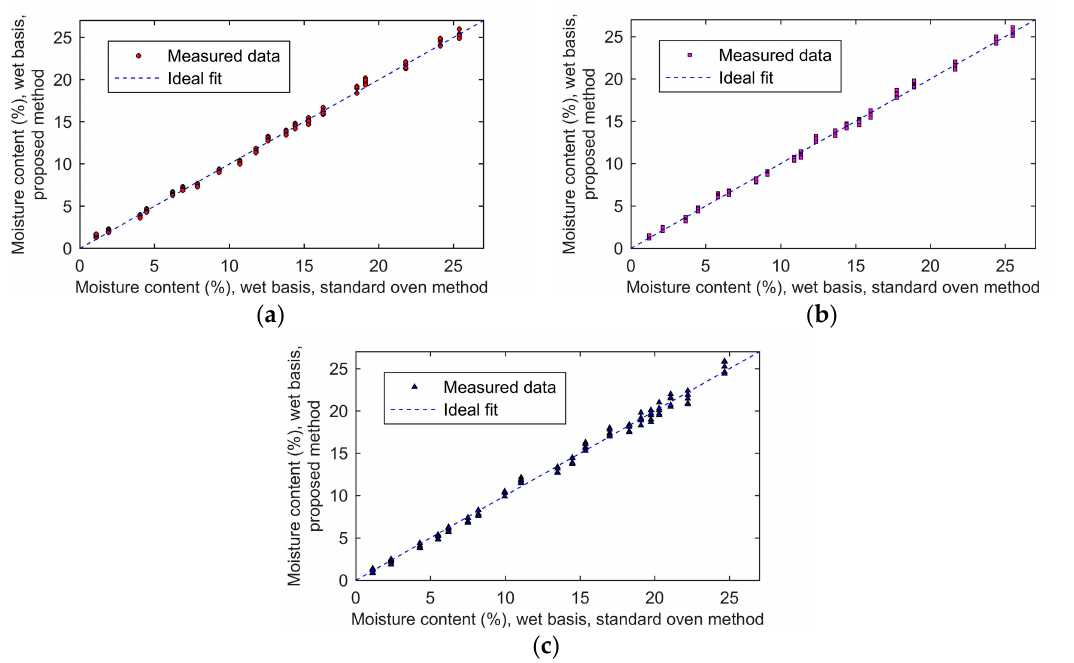
Figure 12. The moisture content of measured results: ( a ), wheat; ( b ), rough rice; ( c ), barley.